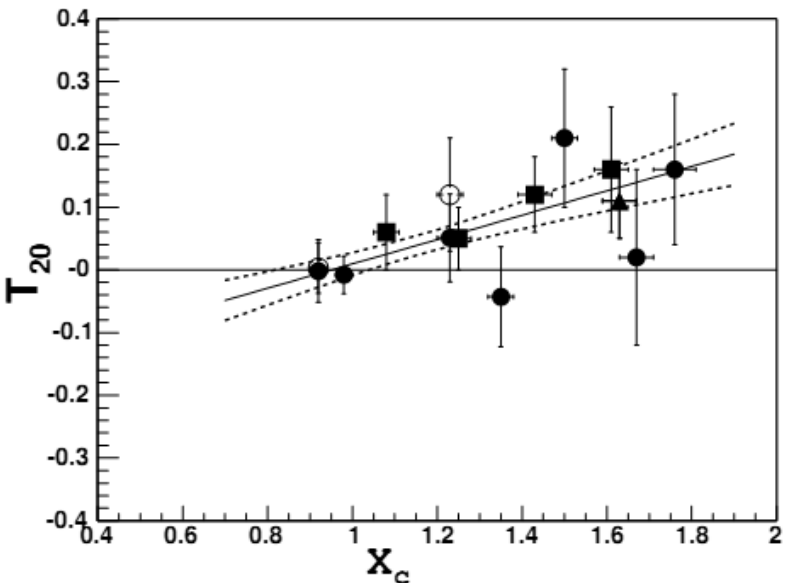
Figure 4. Dependence on the cumulative number X c (see [19]) of the analyzing power of T 20 for the reaction (8): open circles – π + ; A t = 12, closed circles – π − ; A t = 12, closed triangles – π + ; A t = 12, closed squares – π − ; A t = 1, the solid line is the result of fitting with a linear dependence with the errors shown by dashed lines